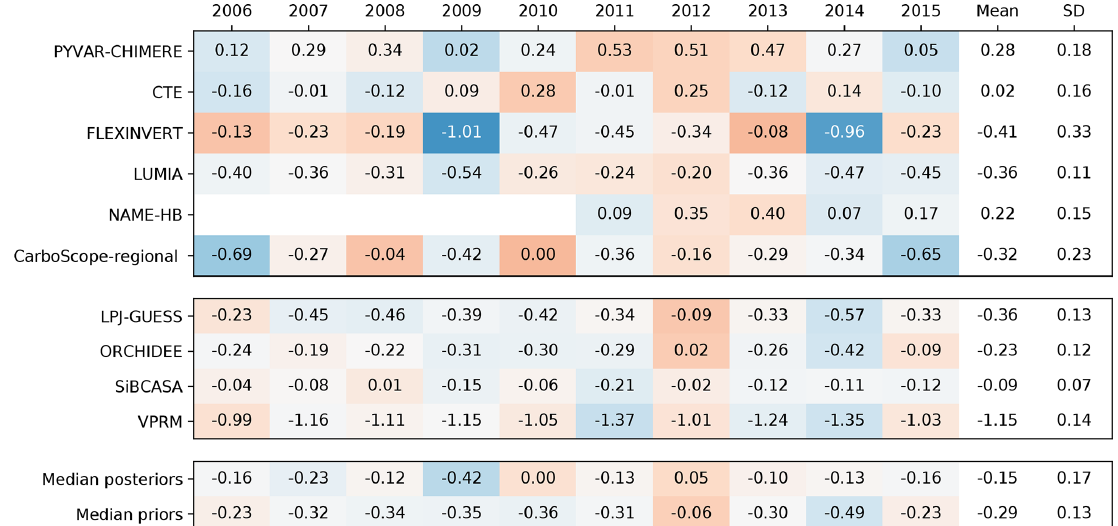
Figure 5. Annual NEE budget (positive for a source to the atmosphere and negative for a sink) for the six inversions (upper section of the array), for the four priors (middle section), and median prior and posterior fluxes (lower section). The two last columns show the mean NEE and the standard deviation of the NEE estimate, respectively, for each simulation. The colours of the cells indicate the strength and direction of the annual NEE anomaly (respective to the mean of each row; see Fig. 6 for the actual